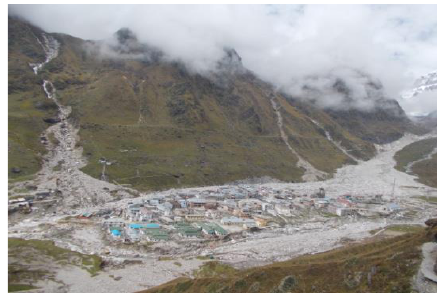
Figure 4. Kedarnath temple